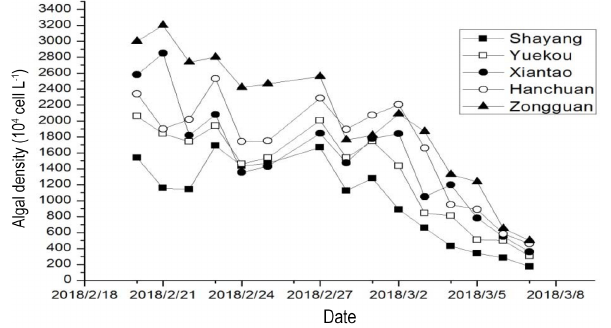
Figure 2. The tendency chart of algal density in each cross section during the outbreak of diatom